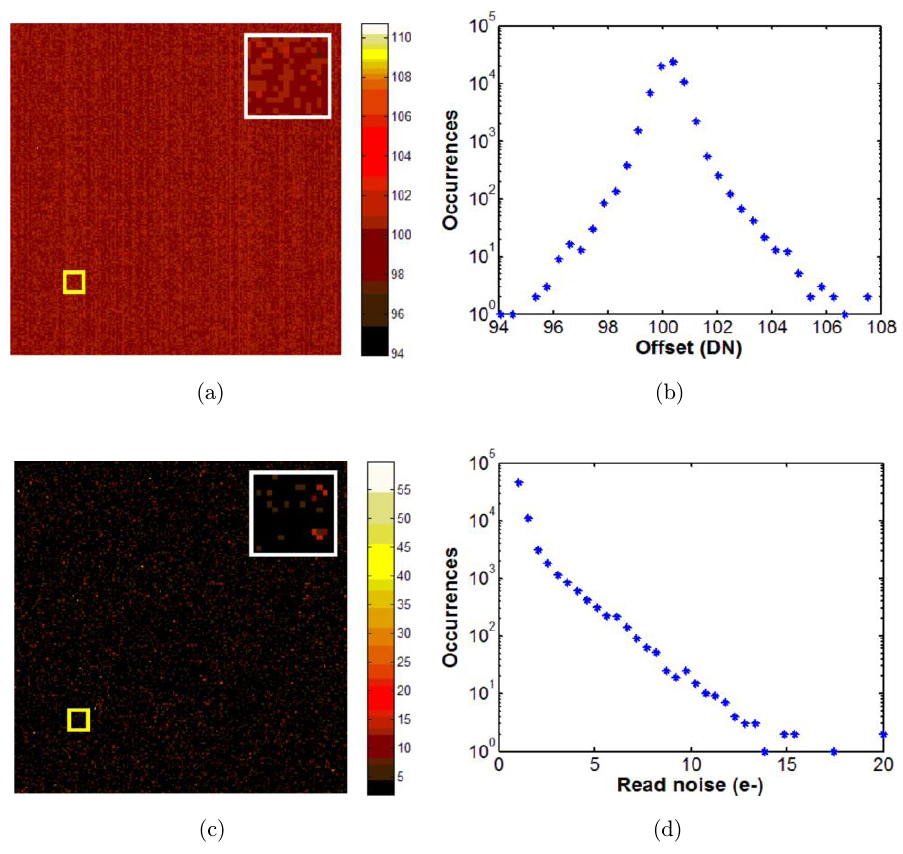
Fig. 6. The pixel-dependent noises of the Hamamatsu Flash 4.0 sCMOS camera. (a) The o®set map and (b) the corresponding histogram. (c) The read noise map and (d) the corresponding histogram. (e) The Gain map and (f) the corresponding histogram. The enlarged images (15x15 pixels) in the upper right corners of (a), (c) and (e) show local °uctuations of the maps in the regions in the lower left. To measure the Gain map, the signal was linearly increased from 0 to 1000 photon/pixel, and a total of 16 image groups were captured with 1000 raw image frames in each group. The ¯rst group was measured with no incident light. A sub-region of 256x256 pixels was used for all